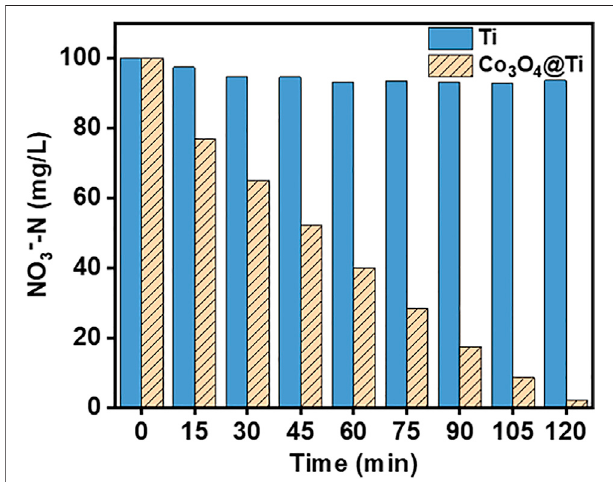
FIGURE 6 | Removal ef fi ciencies of NO 3 − -N by the Ti and Co 3 O 4 /Ti cathodes (Pt anode; [NO 3 − -N], 100 mg/L, 150 ml; current density, 15 mA/ cm 2 ; pH, 7.0; reaction time, 2 h).